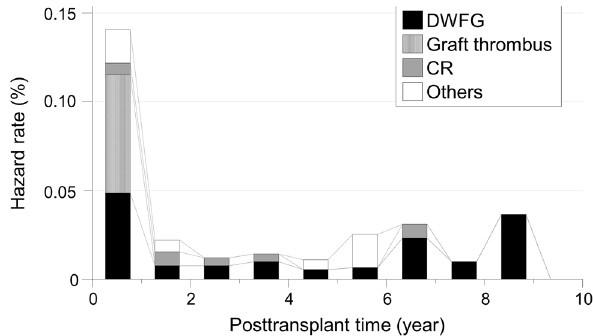
Figure 2. Whole hazard rate of pancreas graft loss within 10 years with its cause in SPK cases. CR chronic rejection, DWFG death with a functioning graft, SPK simultaneous pancreas-kidney transplantation.